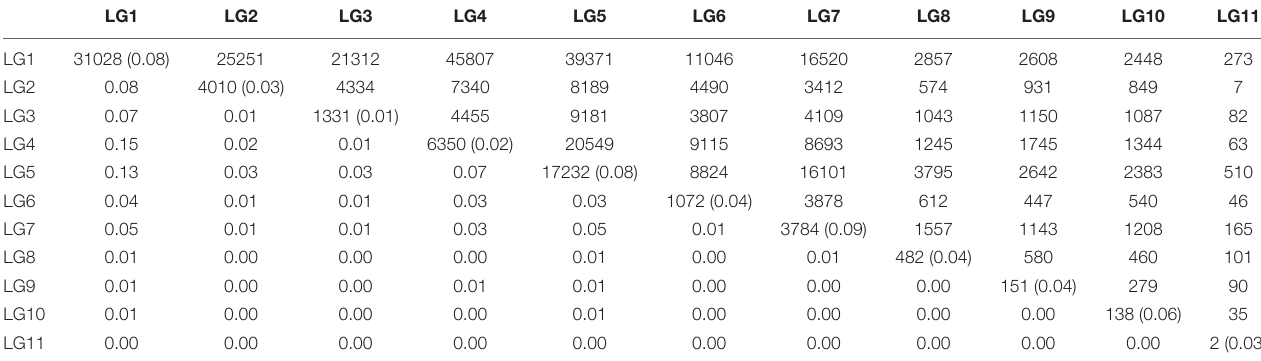
TABLE 2 | The number (upper diagonal) and proportion (lower diagonal) of marker pairs with significant LD within and between linkage groups (LG).